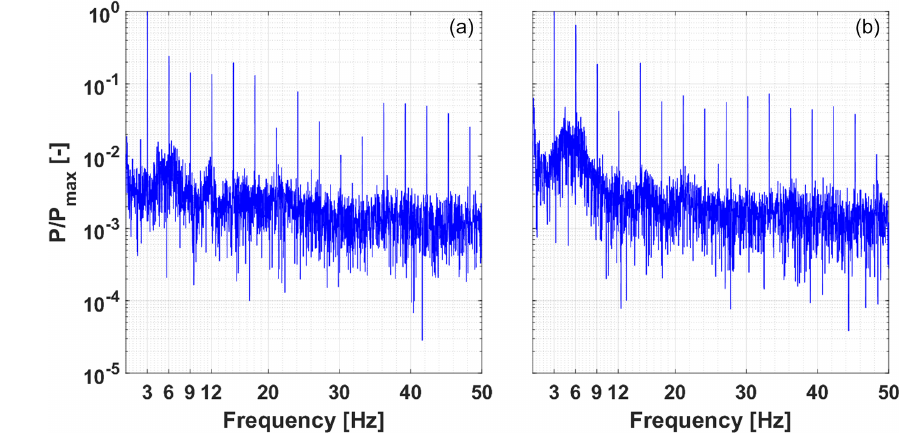
Figure 7. Frequency spectrum of one pressure sensor of the three-hole probe at 75% R (a) . Frequency spectrum of the pressure tap at x = 2% c (b) . Both cases are for a pitch angle of θ = 0 ◦ and yaw angle of 0 ◦ .